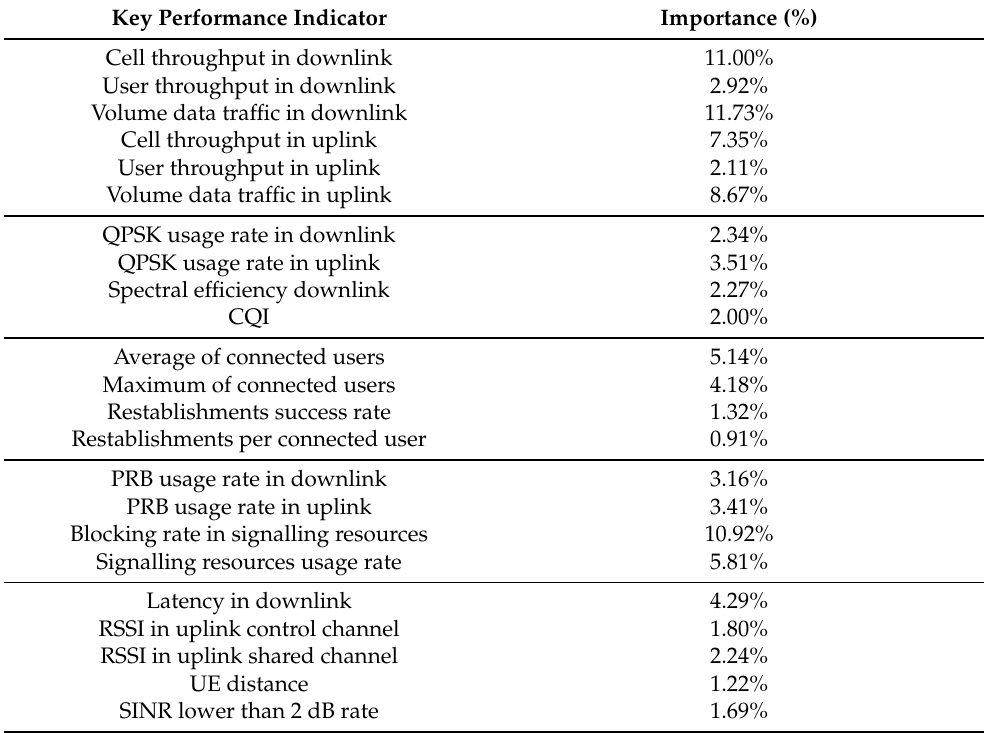
Table 9. Importances of each KPI in classification.